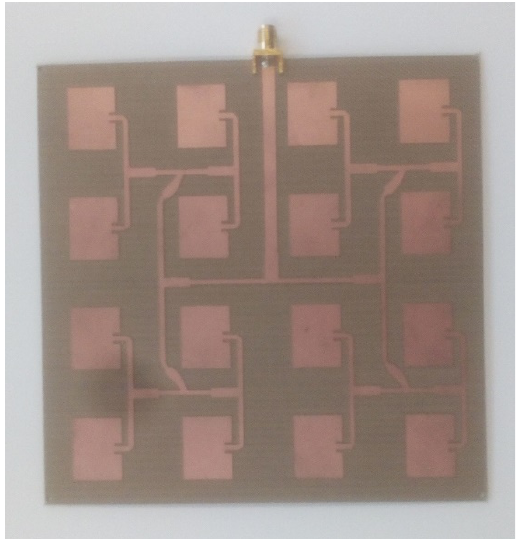
Figure 2. The patch array antenna (14 by 14 cm)